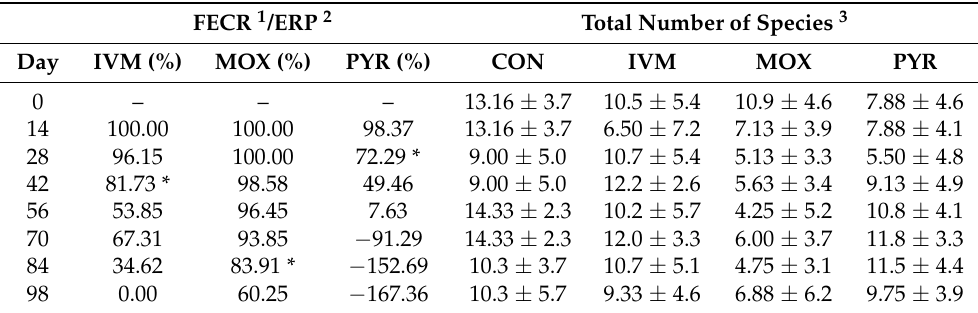
Table 3. Reappearance of cyathostomins over 98 days post deworming with three different an- thelmintics.